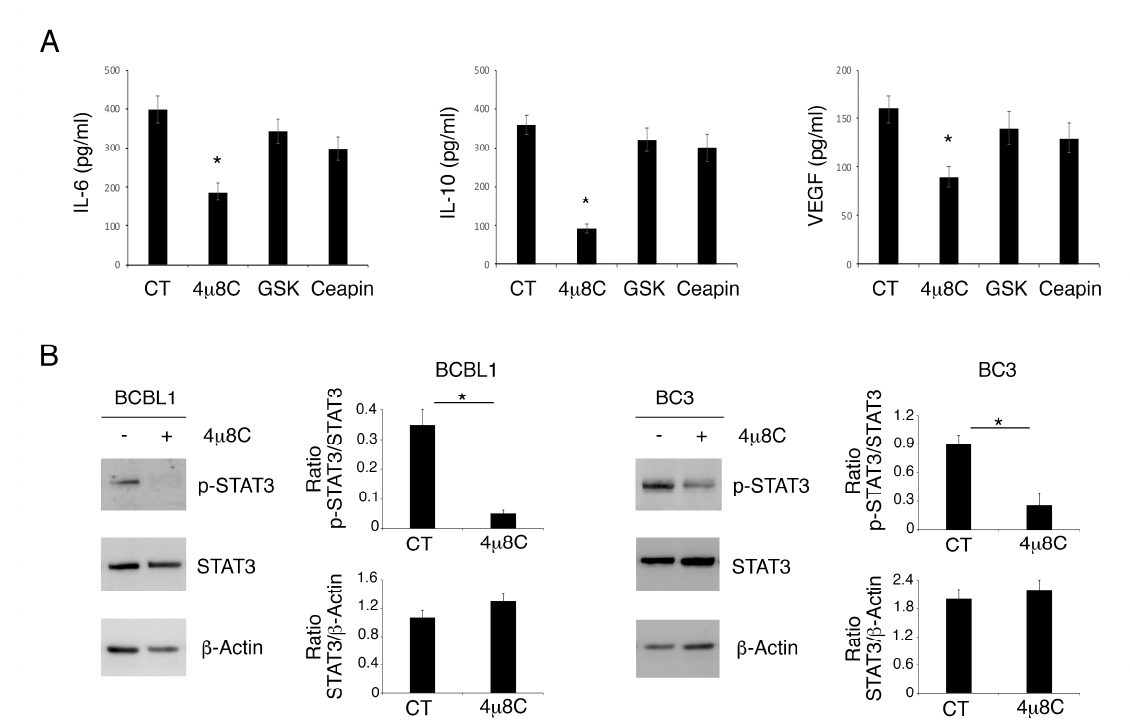
Figure 2. 4µ8C reduces pro-inflammatory/immune suppressive cytokines and inhibits STAT3 phosphorylation in PEL cells. Release of IL-6, IL-10 and VEGF was measured in supernatants of PEL cells treated with 4µ8C (20 µM), GSK (20 ng/mL) and Ceapin (12 µM) or without (CT), ( A ). Histograms representing the mean plus SD of the amount of IL-6, IL-10 and VEGF of three independent experiments are shown. * p -value < 0.05. ( B ) The expression of p-STAT3 and STAT3 in BCBL1 and BC3 cells treated or not (CT) with 4µ8C (20 µM) was evaluated by Western blot analysis. Actin was used as loading control. A representative experiment out of three is shown. Histograms represent the mean plus SD of the densitometric analysis of the ratio of p-STAT3/STAT3 and STAT3/ β -actin. * p -value < 0.05.